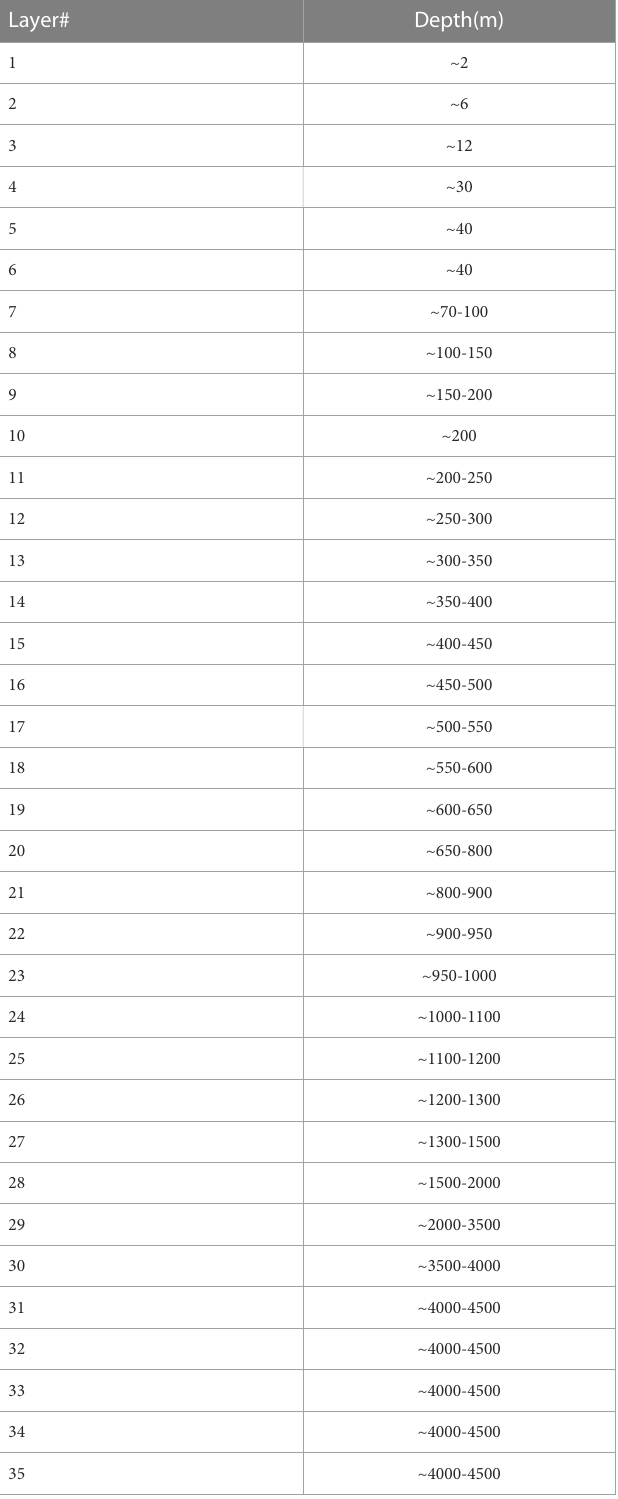
TABLE 1 List of approximate layer depth ranges for the region south of the Yucatan Channel and north of 18